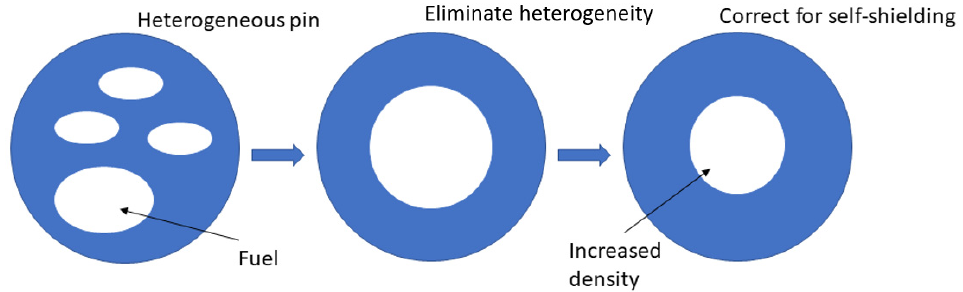
Figure 1. A diagrammatic representation of the core principle of previous uses for the RPT. A highly heterogeneous pin/fuel pellet is simplified to allow lattice calculations in 2D, and then the self-shielding differences which result from the geometric manipulation are corrected for by a manipulation of the density and radius of the fuel.